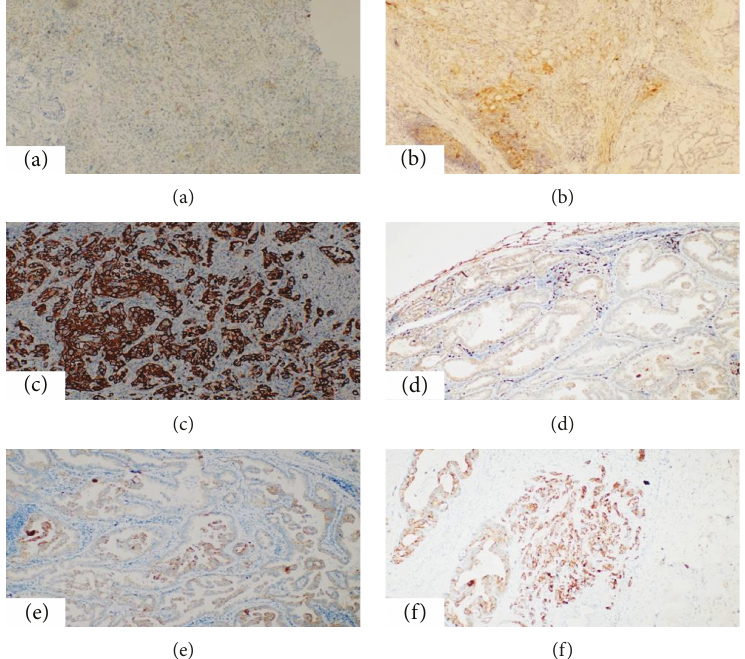
Figure 2: MHC-1staininginprimarytumorandmetastaticlymphnodeingastriccancer.(a)Primarytumor(noMHC-1staining).(b)Primary tumor (low MHC-1 staining). (c) Primary tumor (high MHC-1 staining). (d) Metastatic tumor (no MHC-1 staining). (e) Metastatic tumor (low MHC-1 staining). (f) Metastatic tumor (high MHC-1 staining). All images × 100 magni fi